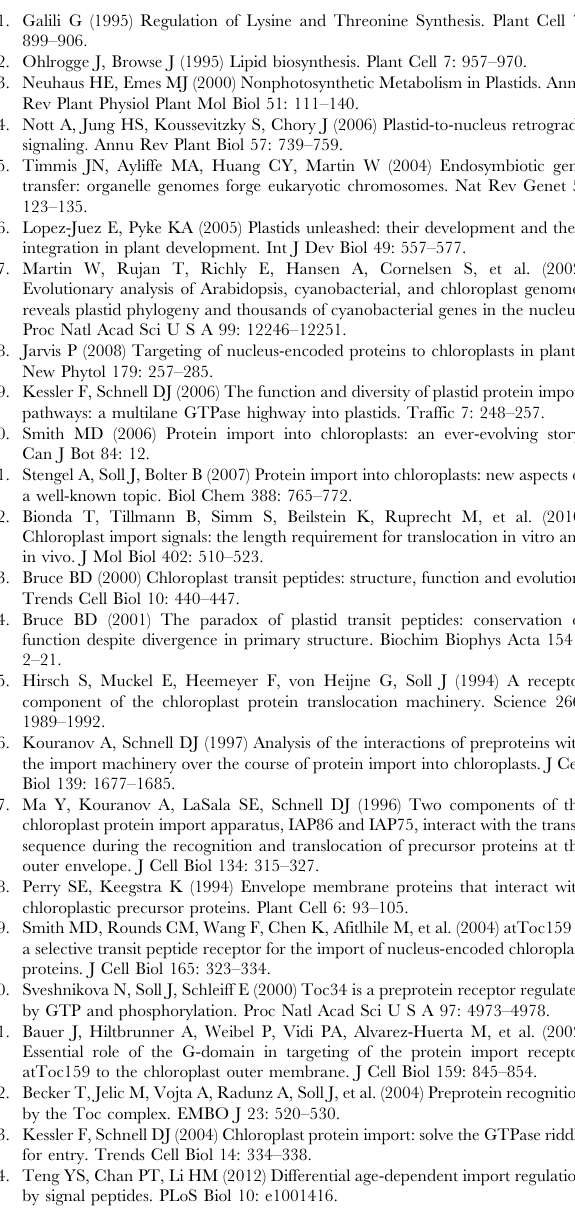
Figure S3 Qualitative assay of the reporter gene LacZ using X-Gal as a substrate. An X-Gal filter assay was carried out for all of the positive interaction colonies isolated from (A) the Toc159G-domain screen, (B) the Toc132G-domain screen, and (C) the Toc132AG screen (Table 1 and 2). Positive colonies from the screens were re-streaked on the SD-LW media plates and incubated at 30 u C for 3 days prior to the assay. The test was made on filter papers as described in the material and methods. The blue coloration developed after 30 min. A positive control bait, pTSU2-APP, with a positive control prey, pNubG-Fe65 (Dualsys- tems Biotech), were used as a positive control interaction for each set. Colonies co-transformed with respective bait and empty library vector pR3-N were selected as negative controls. Labels in the upper panel of each box represent the bait protein/construct and those in the lower panel, represent the prey protein/construct. (TIF)